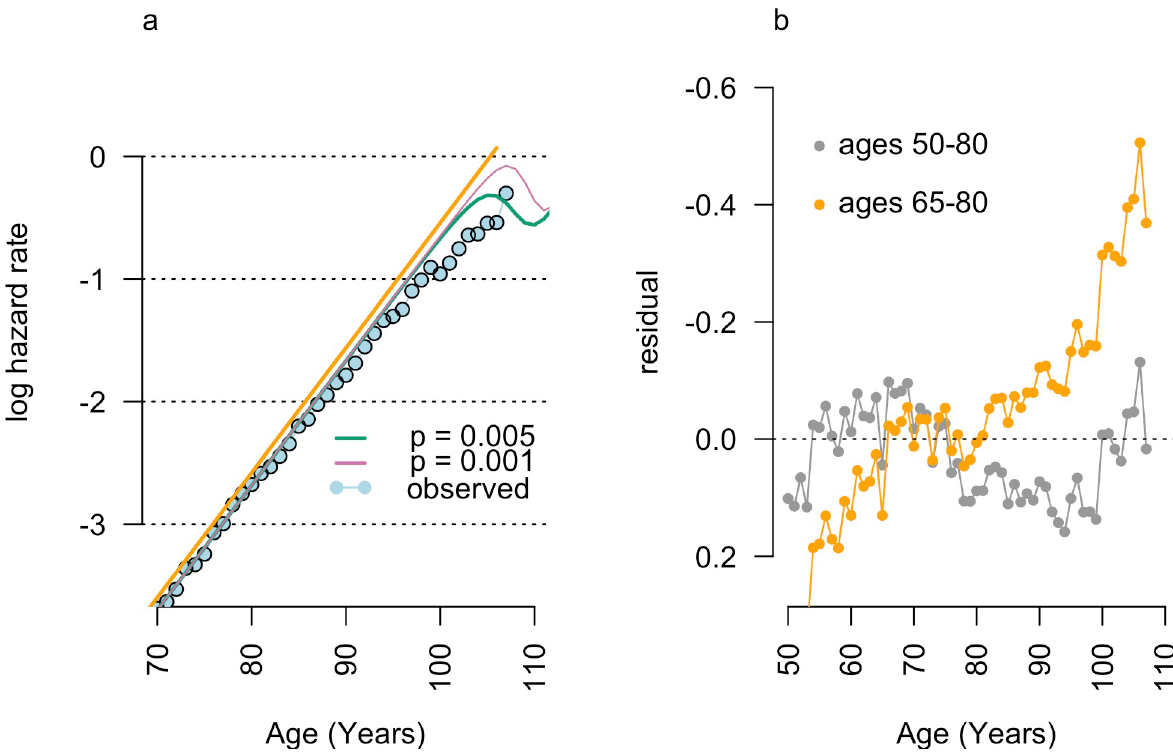
Fig 1. Generation of late-life mortality plateau by random errors. The introduction of symmetrically distributed age-coding errors (a) into the log-linear model (orange line) fit as a ’best estimate’ to the 1904 cohort data in Barbi and colleagues [1] generates late-life mortality patterns (green and pink lines) similar to observed data (blue points) [4]. Residuals from observed data (b) illustrate the skewed residuals of this model compared with more representative regressions of hazard rates, such as the ages 50–80 model shown (grey).